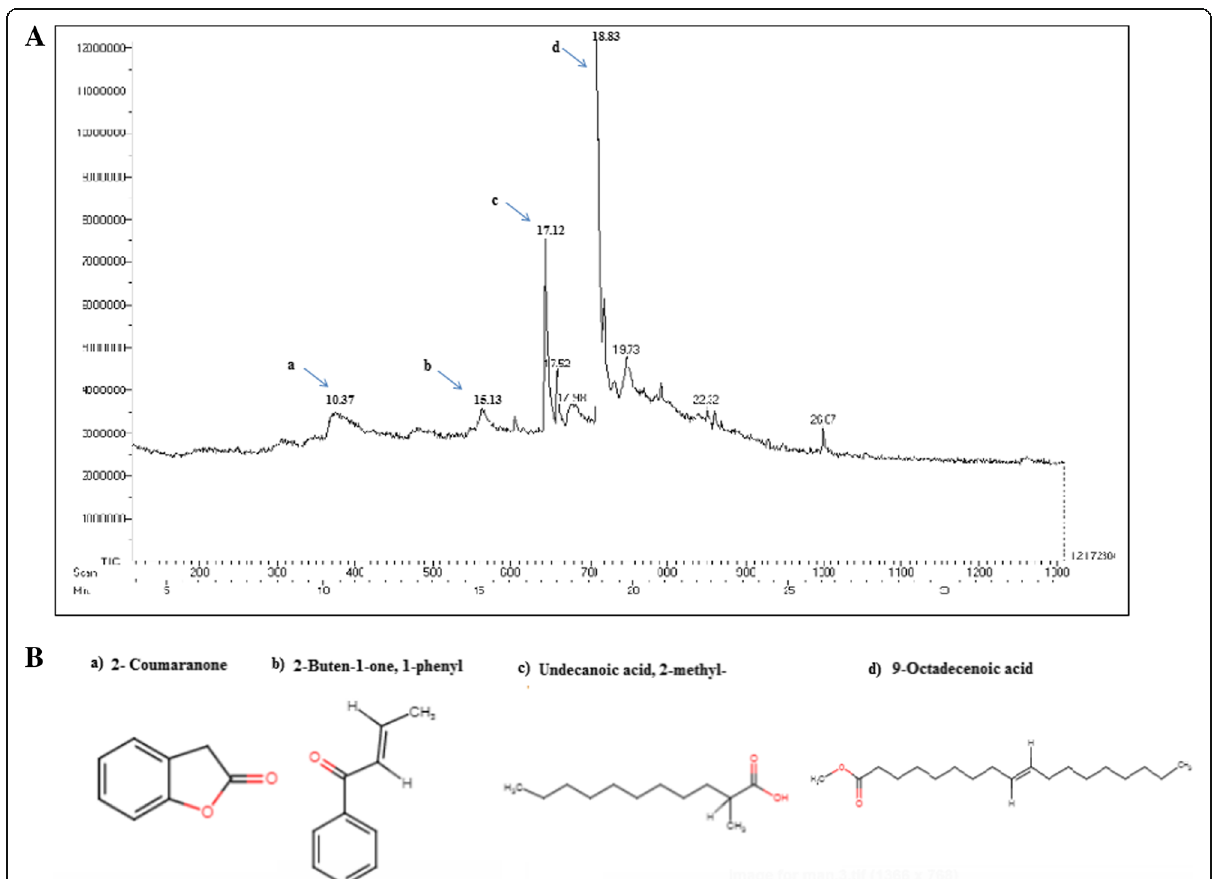
Fig. 1 GC-MS analyses of AR rhizome. ( a ) GC/MS chromatogram of Astibe rivularis rhizome analyzed on GC system. It showed the presence of nine compounds. ( b ) Chemical structures of the active compounds are shown here